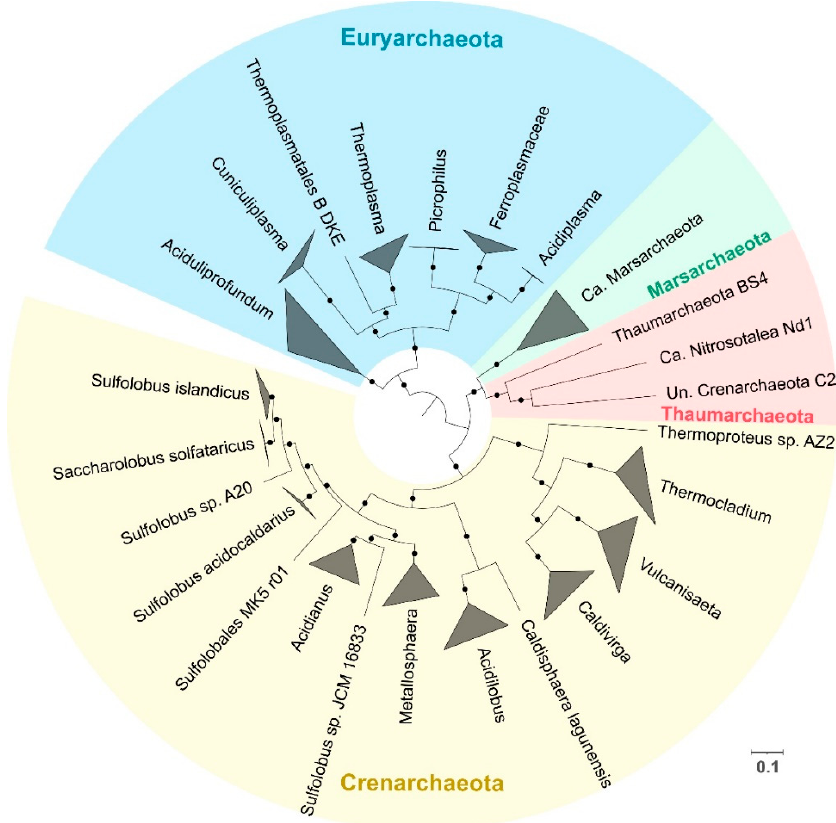
Figure 1. Phylogenetic tree reconstruction of acidophilic archaea with genomes available in AciDB using PhylophlAn 400 markers. Branches are collapsed at genus level, except for Sulfolobus , which is collapsed at species level. Colors represent different phyla associations, with yellow for Crenarchaeota, red for Thaumarchaeota, green for Marsarchaeota and blue for Euryarchaeota. Bootstrap values over 60% are represented by black dots. Abbreviations: Uncultured (Un.); Candidatus (Ca.). Scale bar represents 0.1 amino acid substitution per